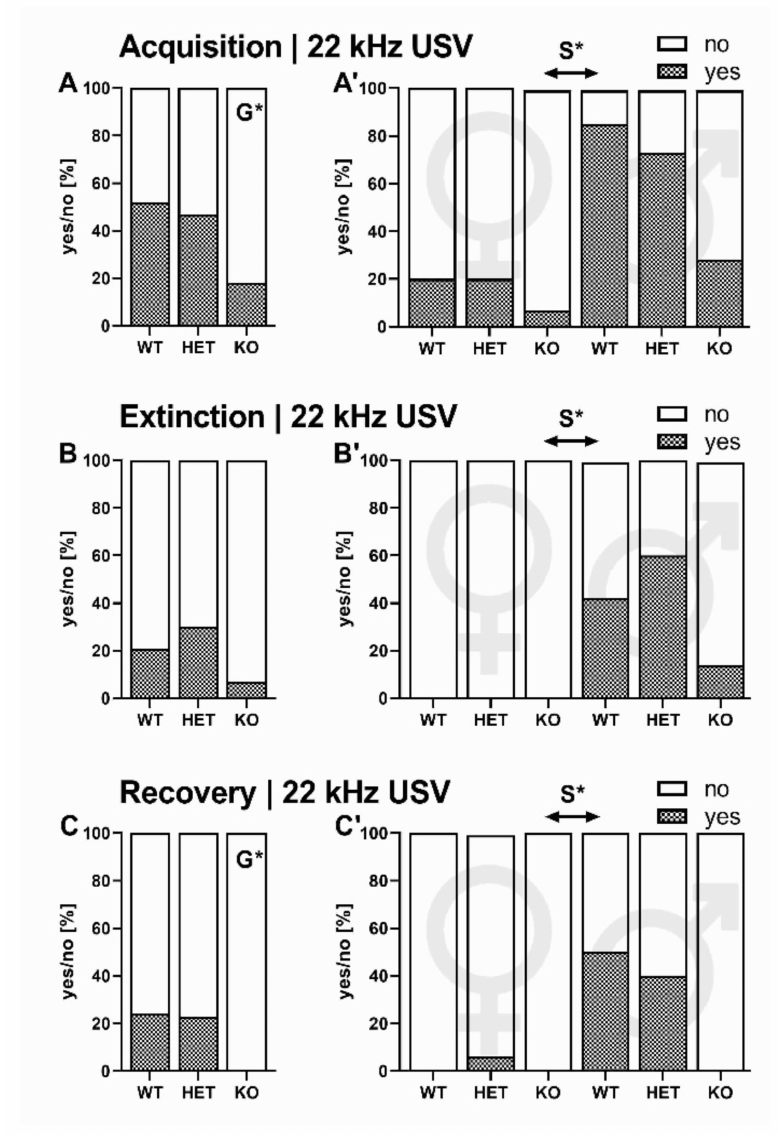
Figure 2. 22-kHz USV prevalence. Effects of SERT deficiency on the prevalence of 22-kHz emission (yes—checkered bar; no—transparent bar) during acquisition ( A , A’ ), extinction ( B , B’ ), and recovery ( C , C’ ). Prevalence of 22-kHz USV is shown for SERT +/+ , SERT +/ − , and SERT − / − rats with sexes pooled ( A , B , C ) and separated by sex ( A’ , B’ , C’ ), with females on the left and males on the right side of the panel. N = 44 female rats (15 +/+, 15 +/ − , 14 − / − ), N = 43 male rats (14 +/+, 15 +/ − , 14 − / − ). Data are presented as mean ± SEM. G* p < 0.05 effect of genotype, S* p < 0.05 effect of